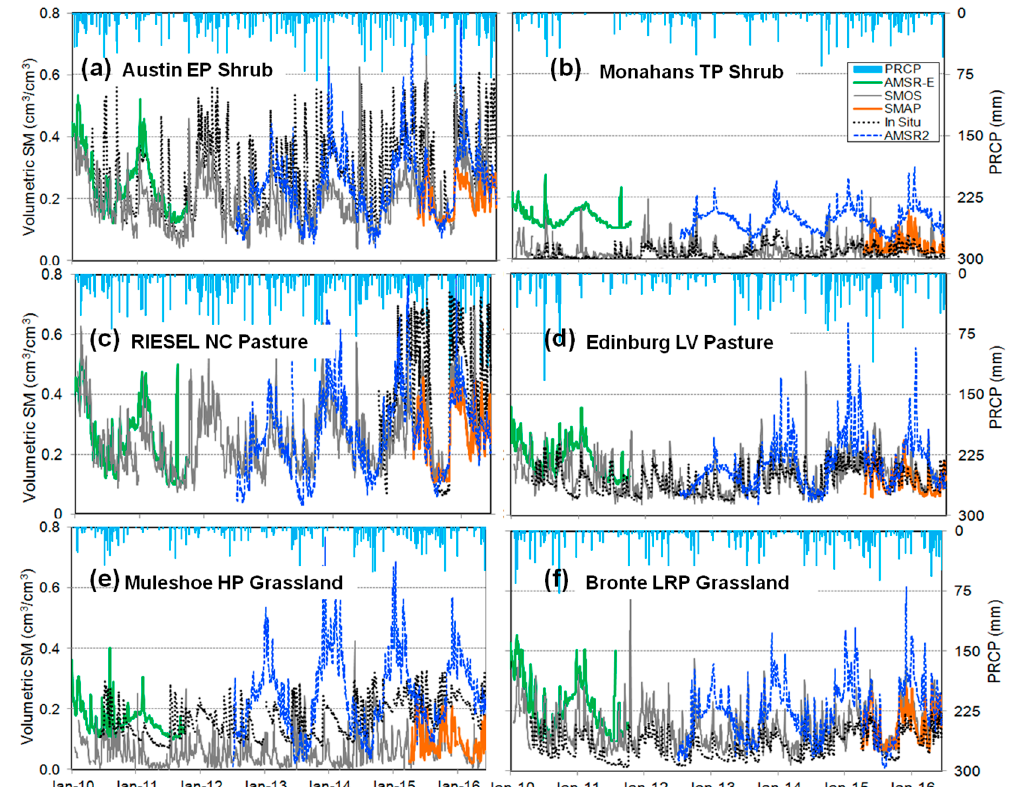
Figure 9. Comparison of satellite soil moisture data for Texas at six selected in situ stations and satellite grids during their overlapping periods (2010–2016). EP = Edwards Plateau; TP = Trans Pecos; NC = North Central; LV = Lower Valley; HP = High Plains and LRP = Low Rolling Plains. Table 3. Correlations among in situ and satellite soil moisture observations (state of